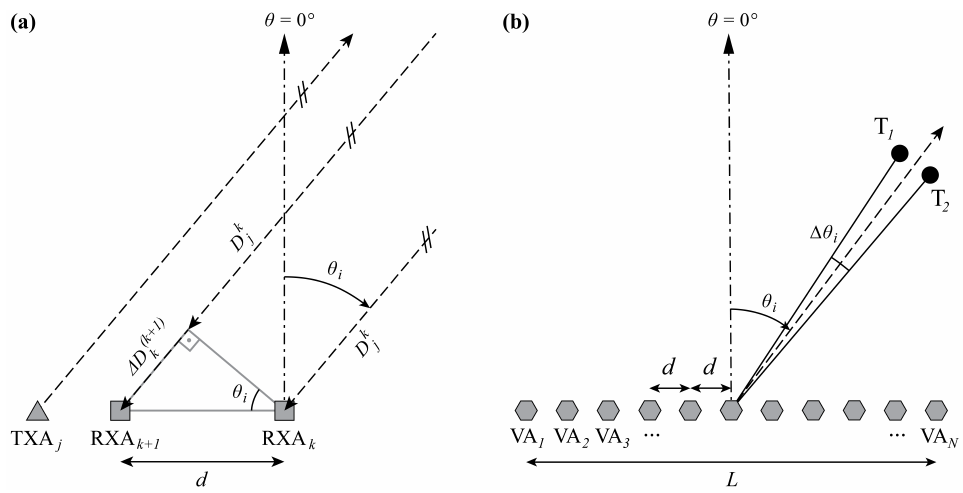
Figure 2. ( a ) Relationship between the angle of arrival θ , the distance d between two receiving antennas, and the phase delay as induced by a difference ∆ D in propagation distances. ( b ) Show- casing the connections between angle of arrival θ with its respective angular resolution ∆ θ and N virtual